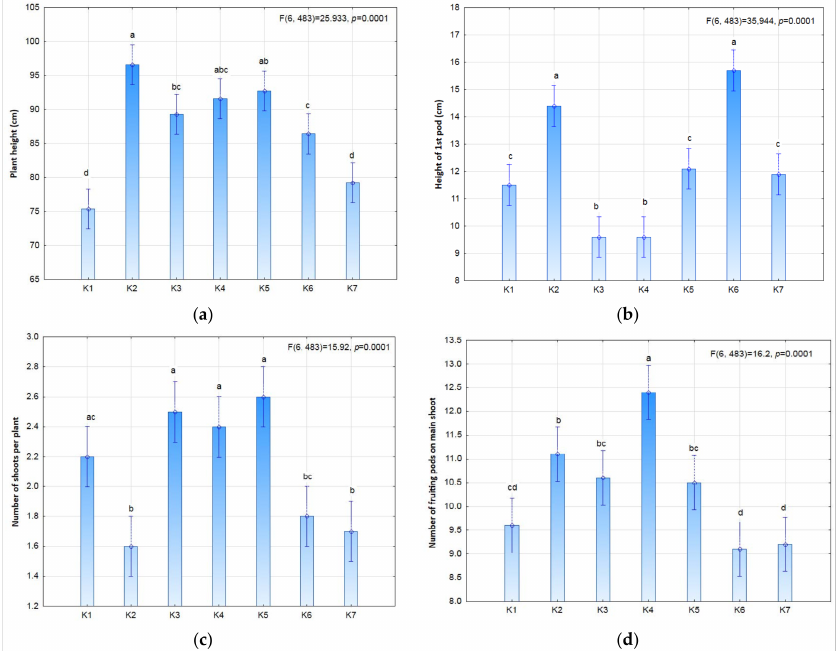
Figure 2. Selected morphological features of soybean ( a ) plant height; ( b ) height of first pod; ( c ) number of shoots per plant; ( d ) number of fruiting pods on main shoot) depending on pho- tostimulation treatment. Different letters indicate significant differences between means. Significant effects at p < 0.05.